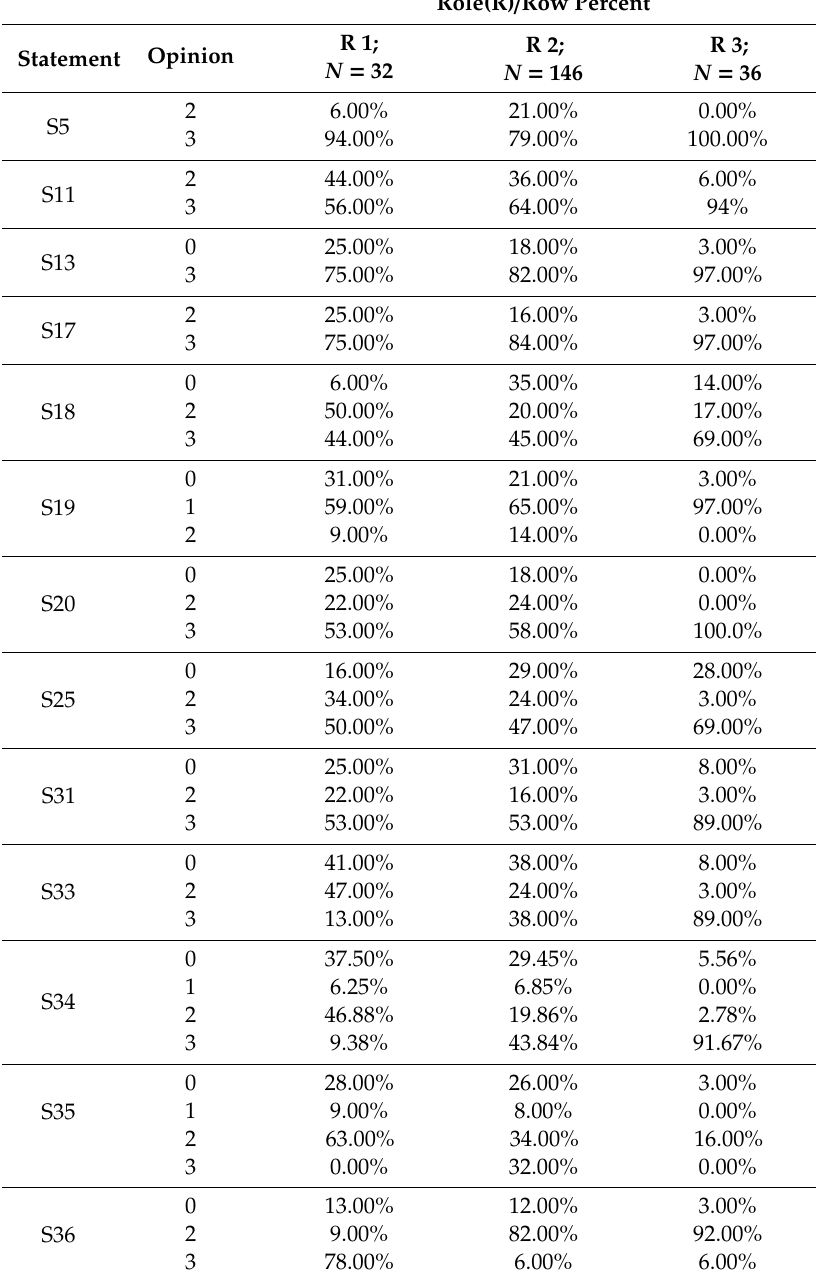
Table 6. Role of participants as a factor significantly influencing opinions and attitudes towards